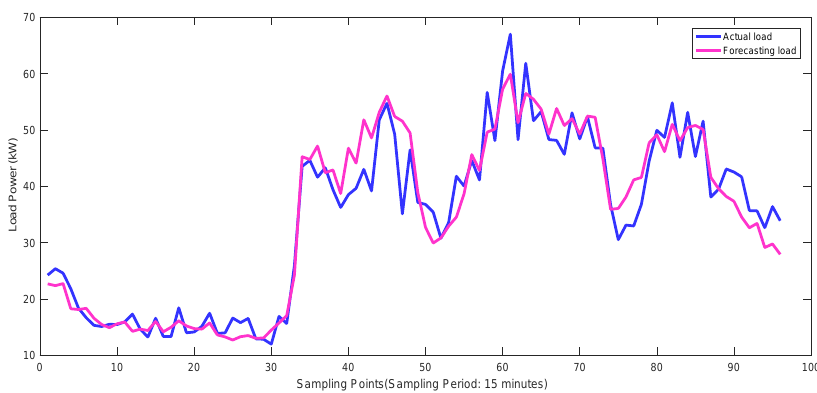
Figure 10. Compared curves of actual load and forecasting load in a day for Customer 53990001.